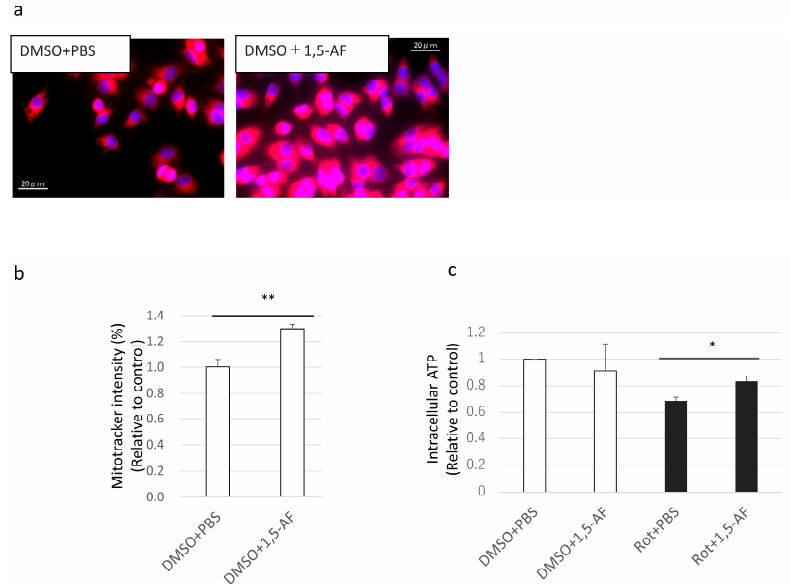
Figure 7. Effects of 1,5-AF treatment on mitochondrial quantity and quality in cultured PC12 cells. ( a ) Representative confocal images of MitoTracker staining (magnification: 100 × ; scale bar: 20 µ m). ( b ) Quantification of the effects of 1,5-AF treatment on MitoTracker intensity from confocal images of MitoTracker-stained cells. ( c ) Effects of 1,5-AF treatment on intracellular ATP levels. All data are expressed as the mean ± standard error of the mean. * p < 0.05, ** p < 0.01. 1,5-AF, 1,5-anhydro-D-fructose; DMSO, dimethyl sulfoxide; PBS, phosphate-buffered saline; Rot, rotenone.